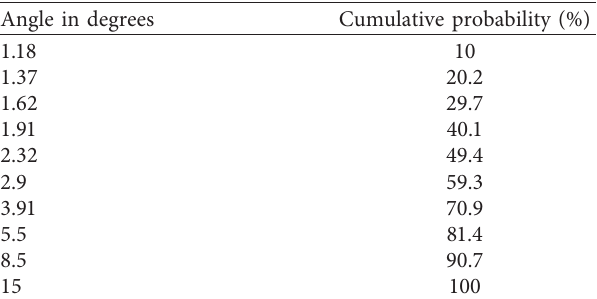
Table 2: The summary of calculated values for the lane angle of the random sample. Angle in